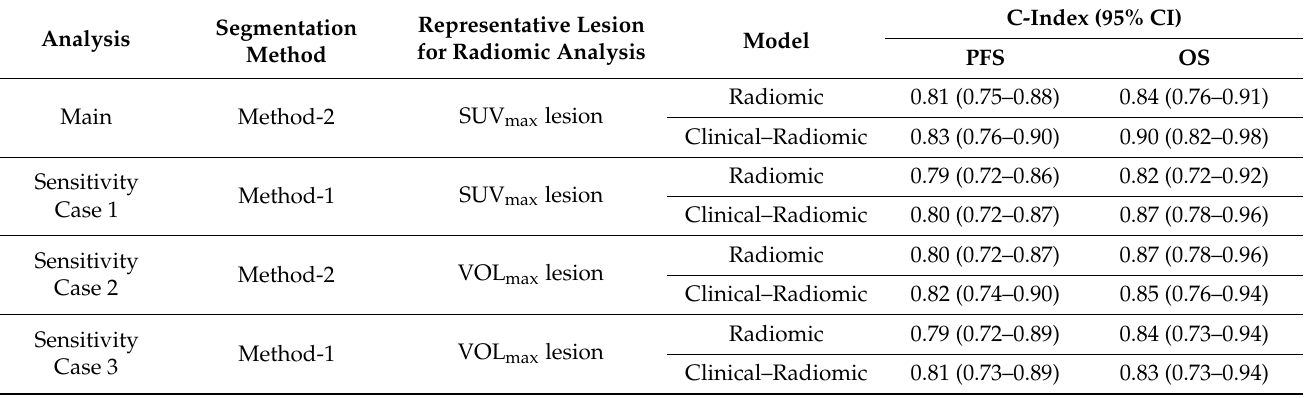
Table 4. C-index (95% CI) values for the radiomic and clinical–radiomic models obtained with the different methodological choices implemented in the main analysis and in the sensitivity